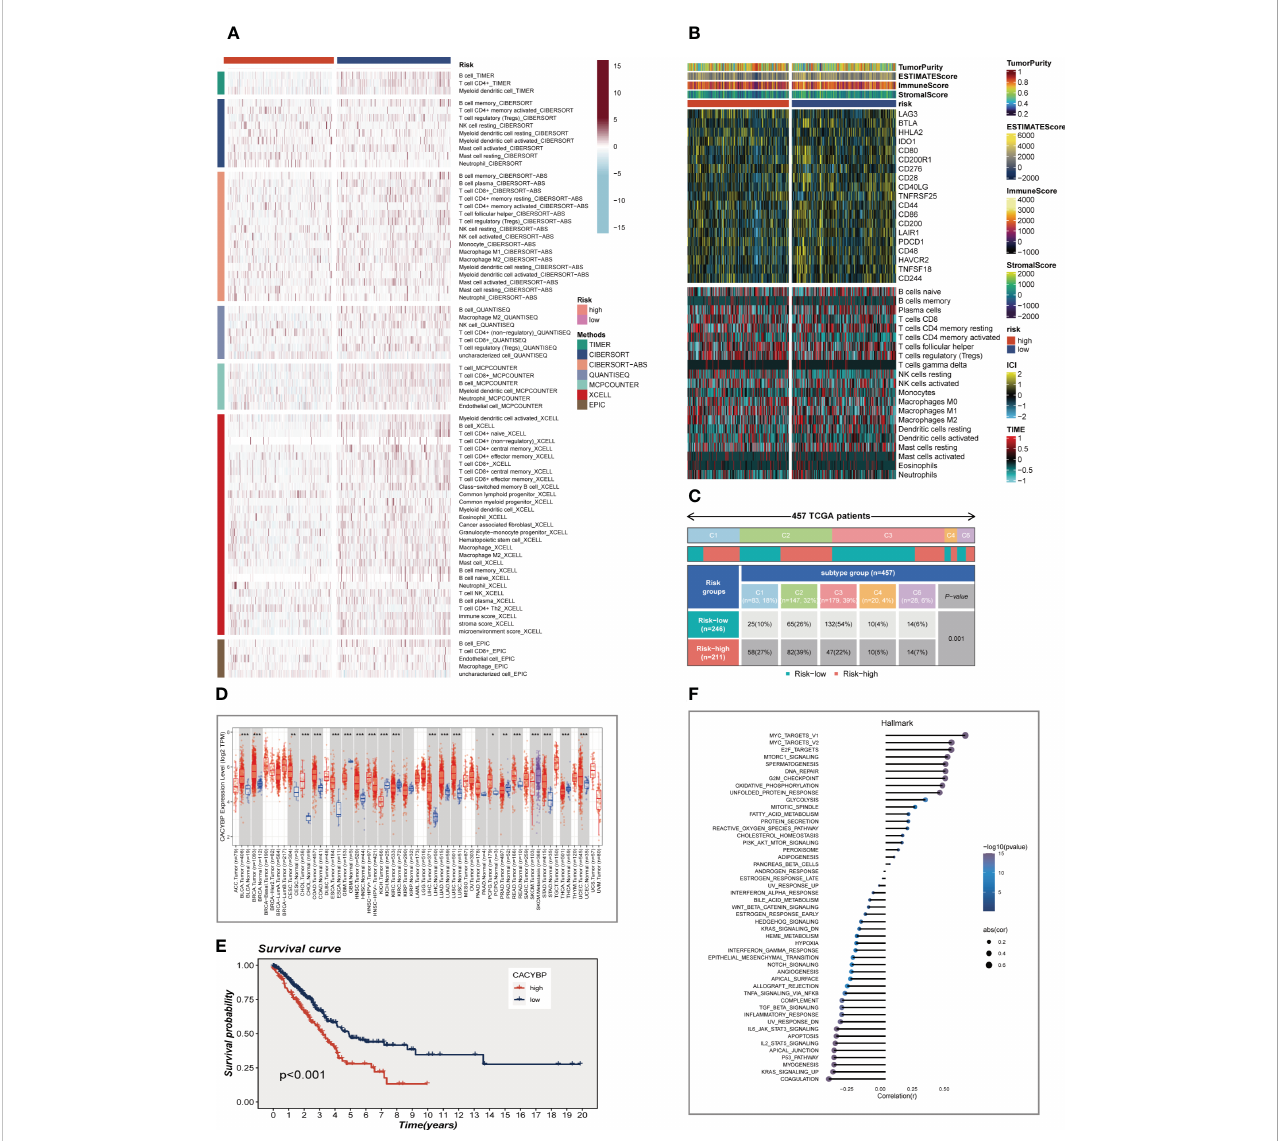
FIGURE 9 Analysis of immunotherapy and the immune microenvironment. (A) Seven algorithms assess differences in immune in fi ltration status between different risk groups. (B) A heat map showed the differences in TME scores, immune checkpoint expression and immune cell in fi ltration calculated by Cibersort among different risk subgroups. (C) Relationship between high- and low-risk groups and six immune subtypes. (D) Boxplot showed CACYBP expression in pan- cancer. (E) Survival analysis showed the effect of CACYBP expression on prognosis. (F) Correlation between CACYBP expression and 50 hallmark pathways. *P < 0.05, **P < 0.01, ***P <